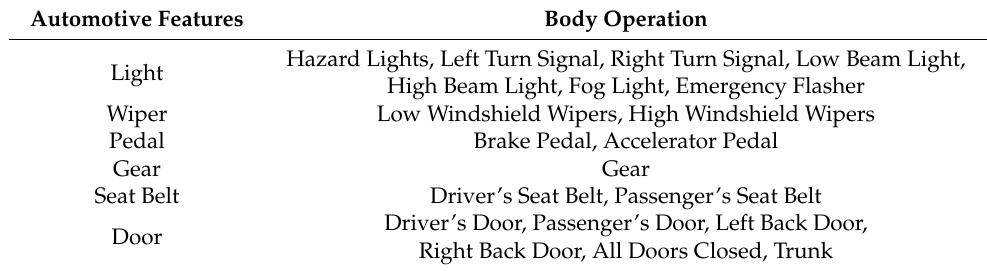
Table 1. Vehicle-body-related functions and operations. Automotive Features